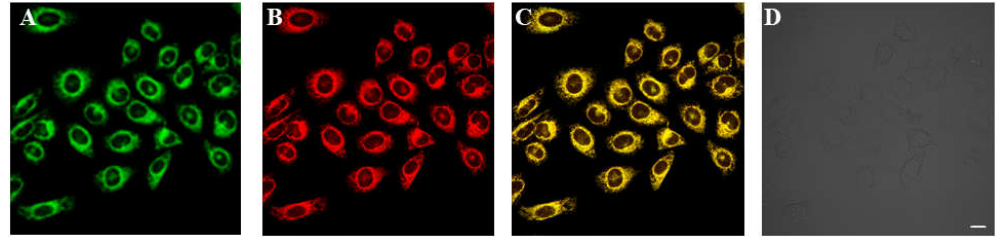
Figure 5. Fluorescence images of mitochondrial ONOO – in HepG2 cells. Cells were stained with 10 μM HDBT-ONOO – or costained with 50 nM MT Deep Red for 60 min, and then stimulated with 1.2 mM SIN-1 for another 90 min before imaging. ( A ) Probe-stained HepG 2 cells were stimulated with 1.2 mM SIN-1. ( B ) Costaining and imaged with MT Deep Red. ( C ) Merged images of (A) and (B). ( D ) Bright field of (A). Images were acquired using a fluorescent microscope (green channel with 458 nm excitation and 510–590 nm collection, a red channel with 633 nm excitation and 650–700 nm collection). Scale bar: 30 μm.